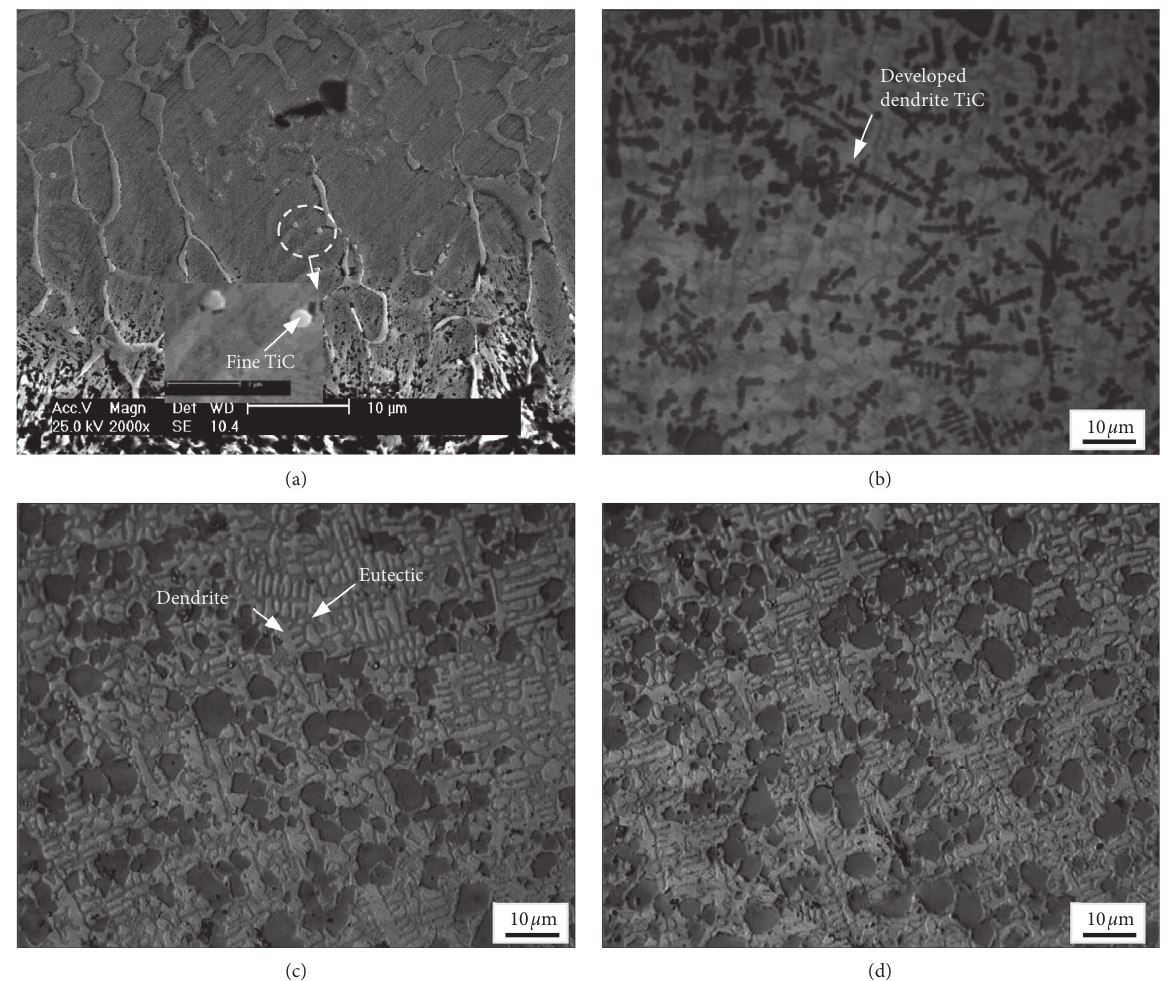
Figure 8: TiC morphologies in different regions of S2 coating: (a) bonding zone; (b) bottom part; (c) middle part; and (d) upper